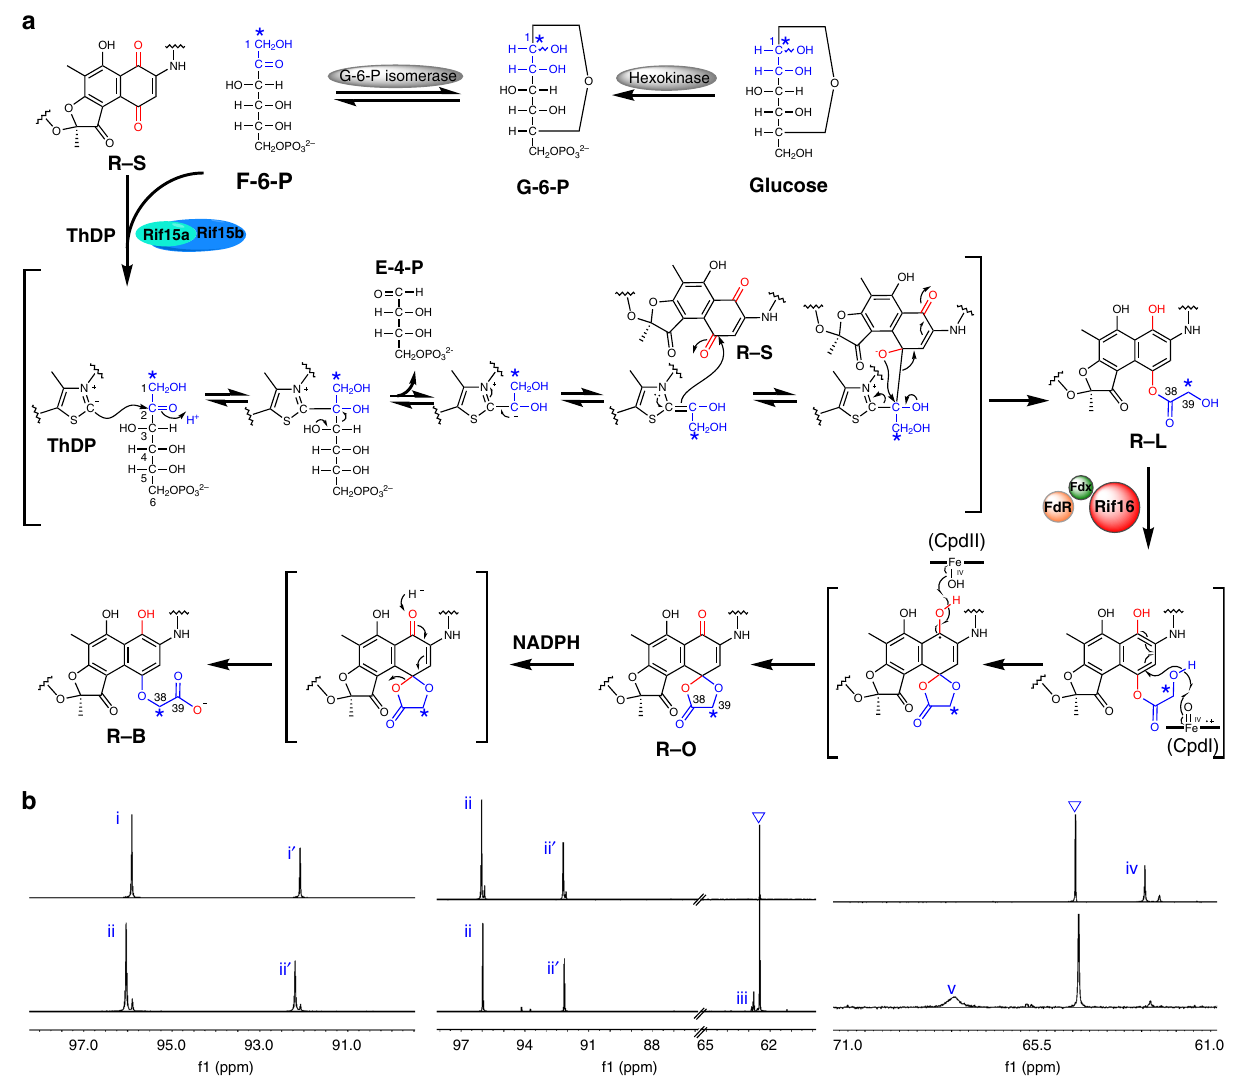
Fig. 3 Putative mechanisms for Rif15 and Rif16 supported by 13 C-tracer NMR results. a The proposed catalytic mechanisms for Rif15 and Rif16. The 13 C labeled carbons marked by asterisks originate from [1- 13 C]glucose. b The 13 C NMR spectra of [1- 13 C](±)-glucose (i, i ′ ), [1- 13 C] (±)-G-6-P (ii, ii ′